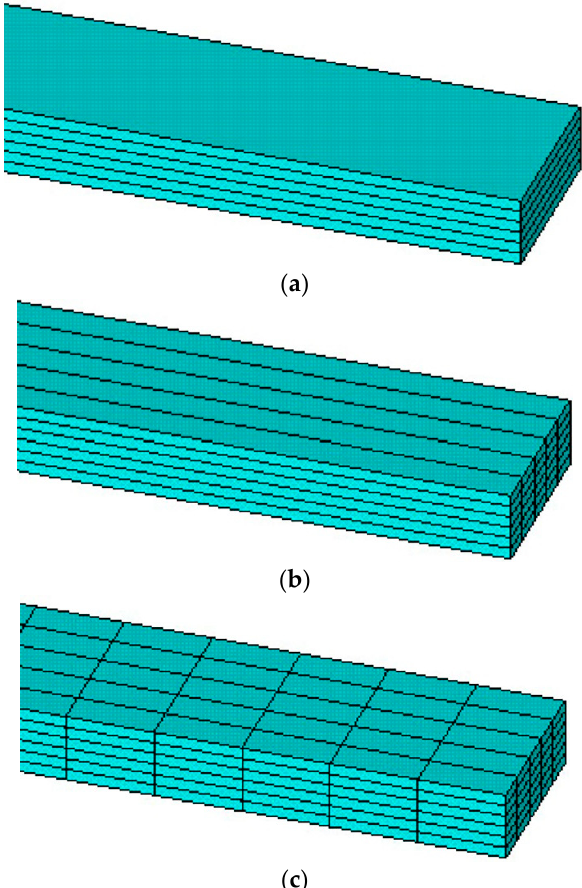
Figure 18. Increasing the degree of detail of the heat source trajectory: ( a ) solid (1 step—1 layer); ( b ) beads (1 step—1/5 of the layer); ( c ) sections (1 step—1/40 of the layer).